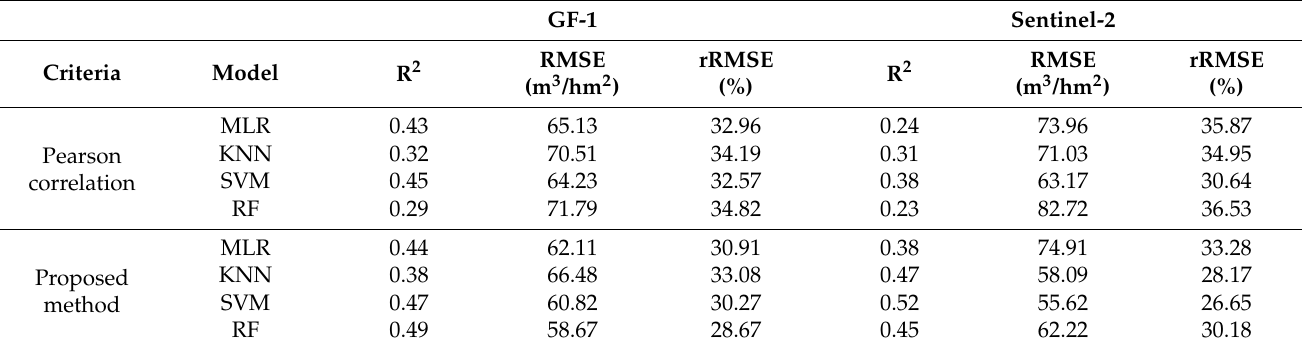
Table 7. GSV estimated with various feature selection methods.